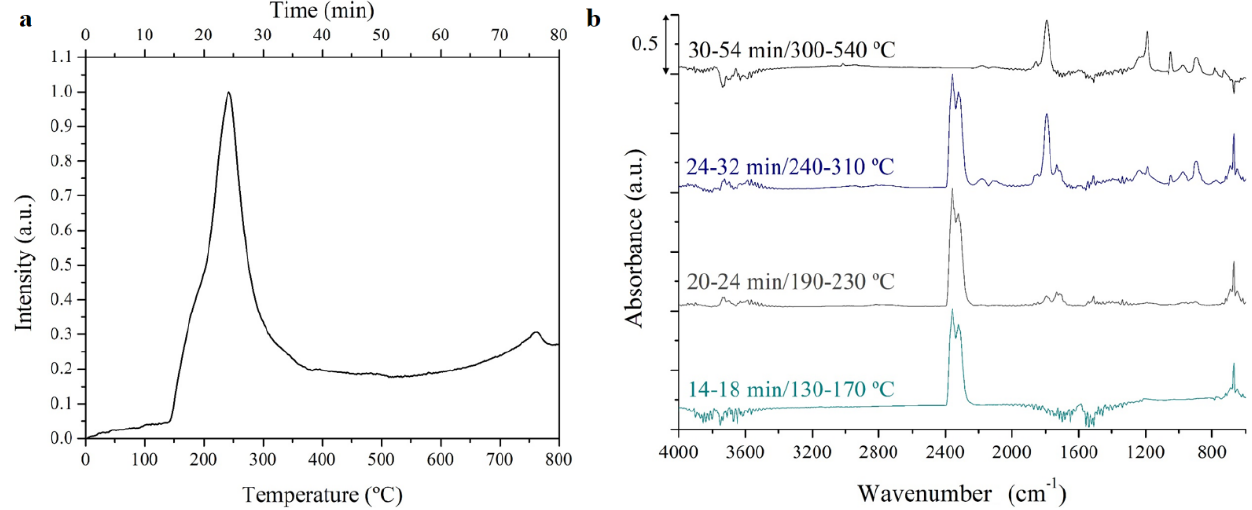
Figure 13. ( a ) Gram–Schmidt over time and temperature and ( b ) FTIR spectra recorded at different intervals for PE2 sample.